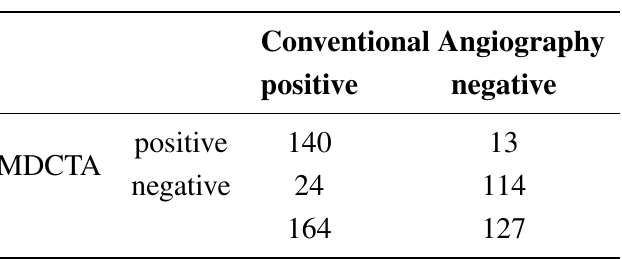
Table 3. CAD data.